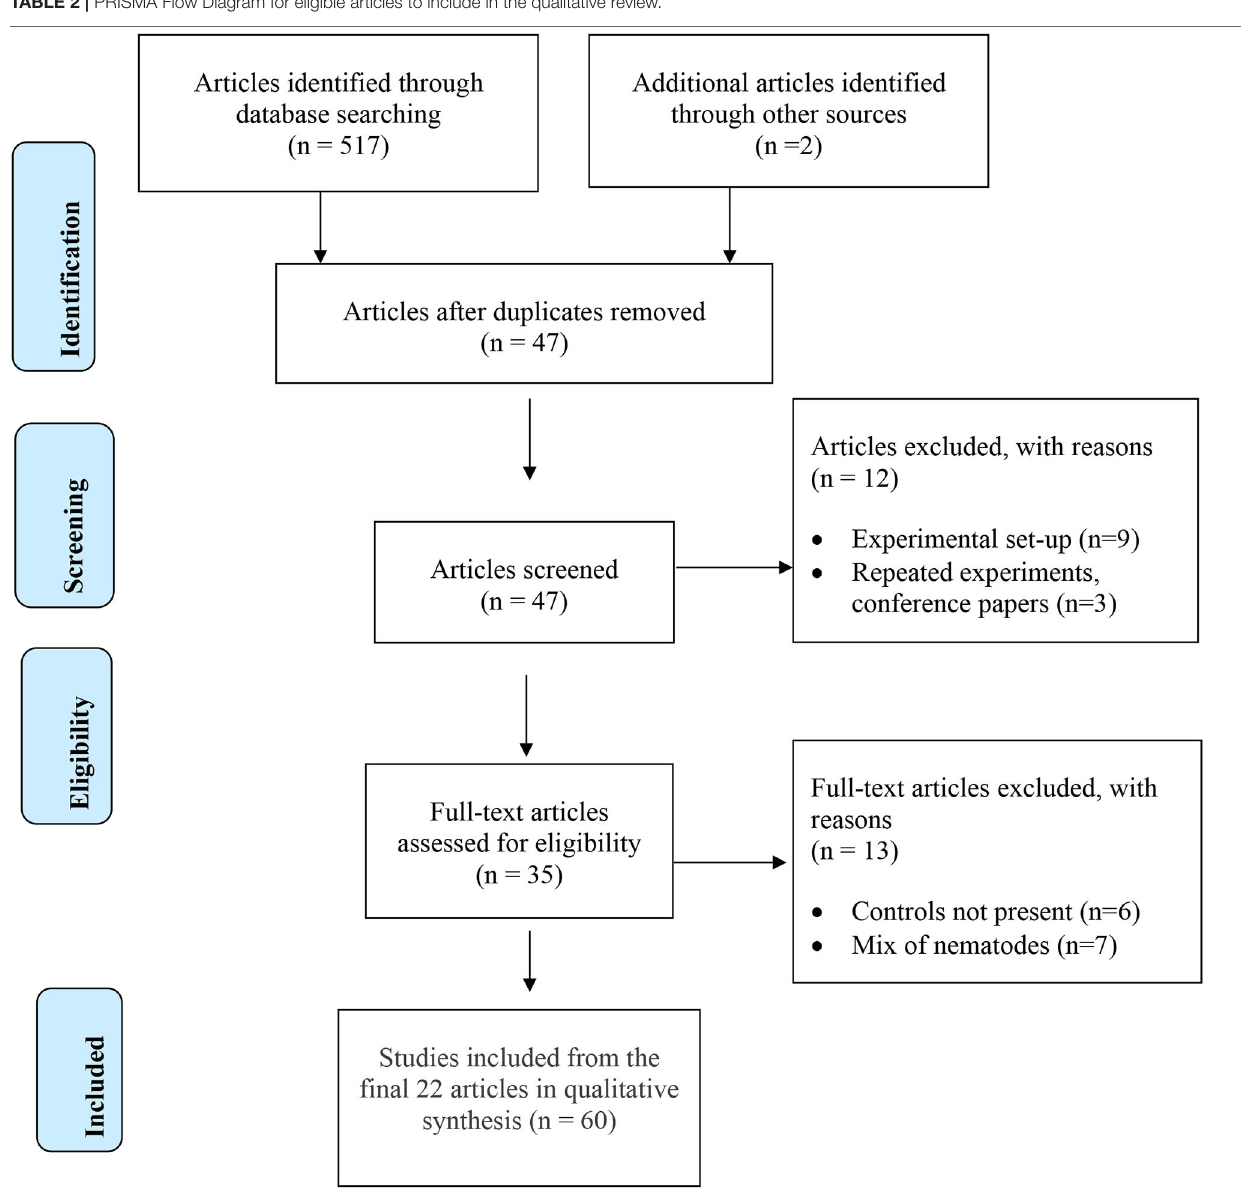
TABLE 2 | PRISMA Flow Diagram for eligible articles to include in the qualitative